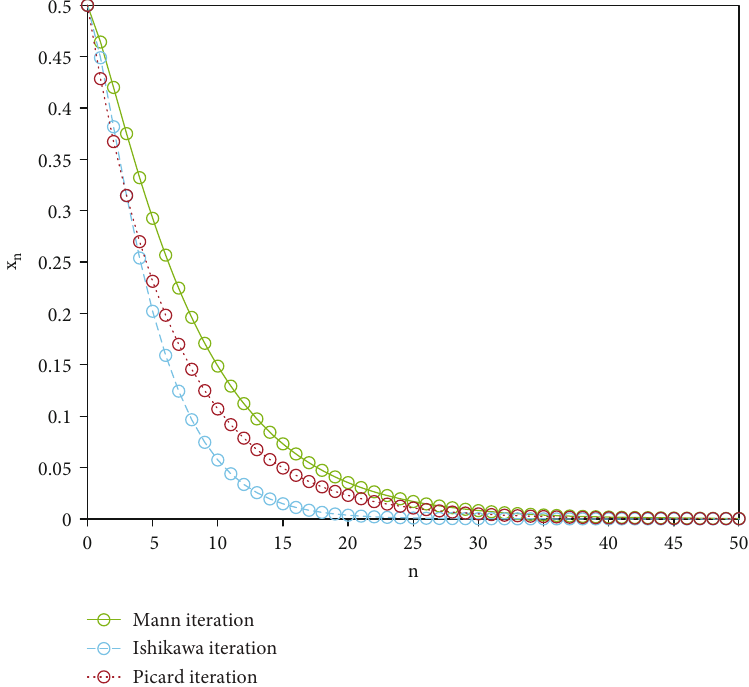
Figure 1: Convergence behavior of the three iterative processes to the fi xed